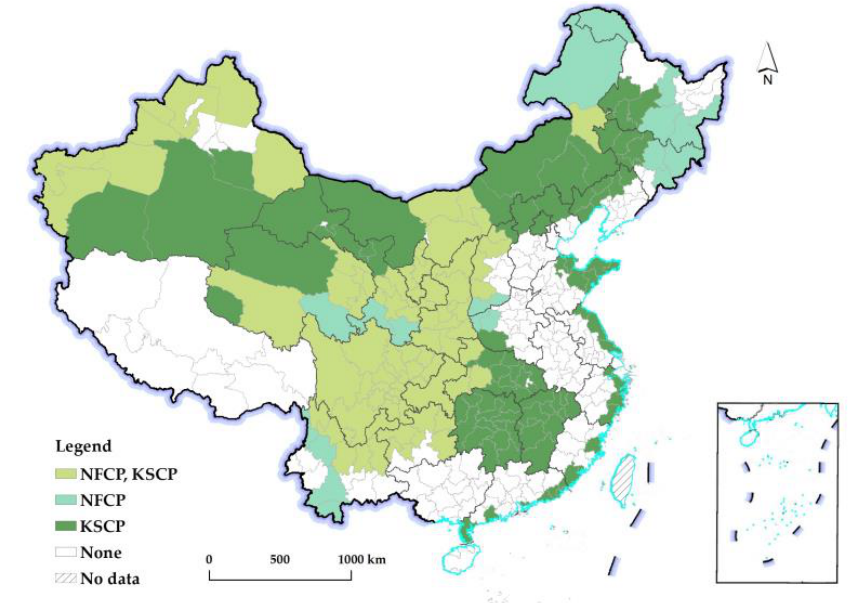
Figure 3. The spatial distribution of the NFCP and